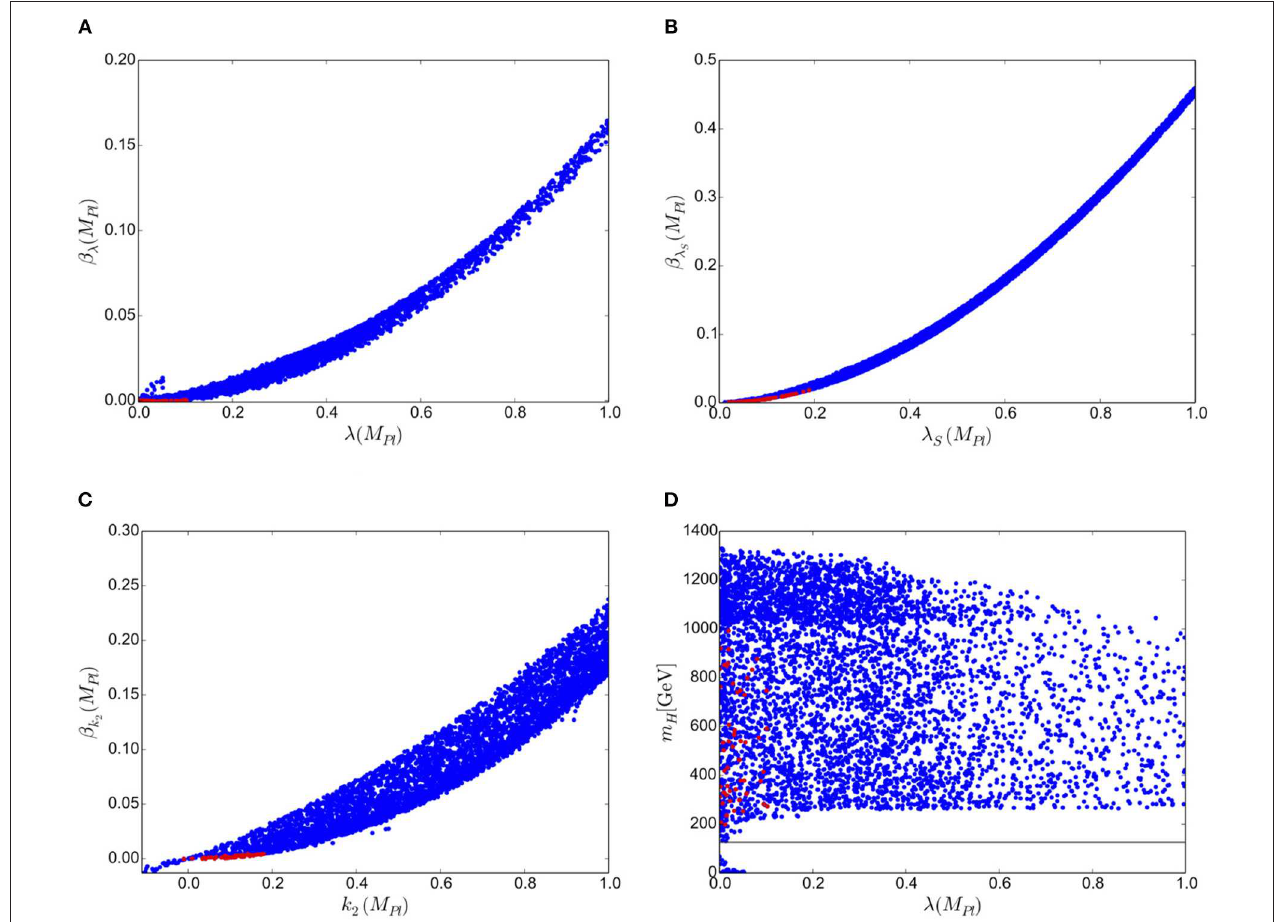
FIGURE 4 | Values of (A) λ ( M Pl ), (B) λ S ( M Pl ) and (C) λ ( M Pl ) compared to their respective β -functions in the broken phase. All points pass theoretical and experimental < 0.019, β k < 0.0045 at M Pl . Also shown (D) is the mass of the additional Higgs for values of λ ( M Pl constraints. Red points further obey β λ < 0.0009, β λ S 2